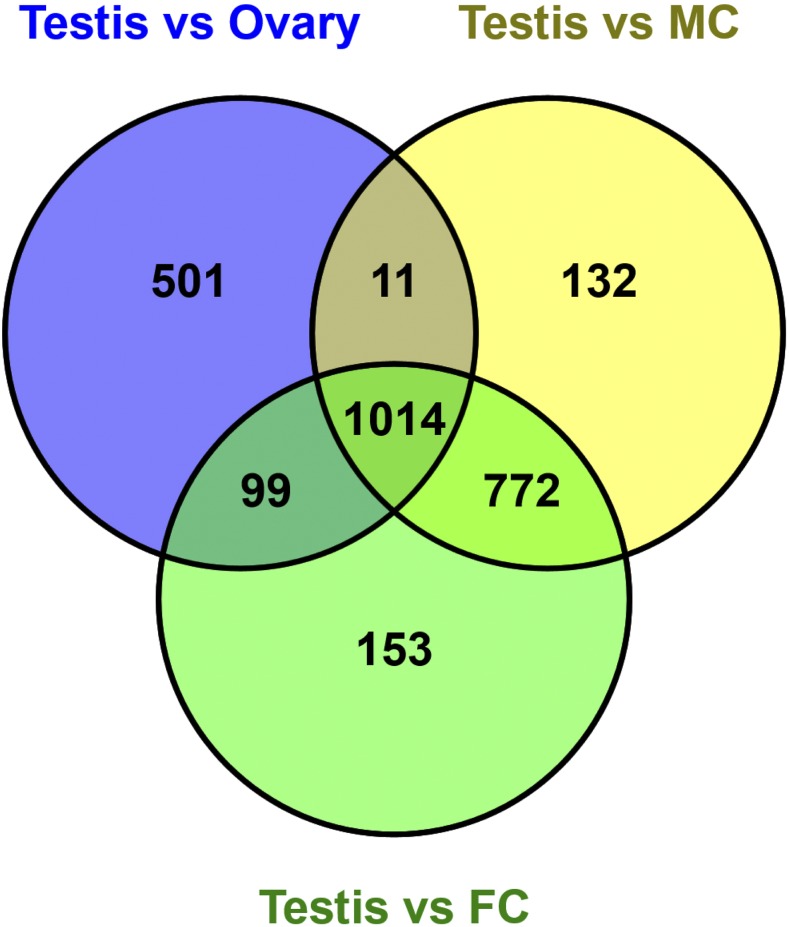
Differential increased gene expression in the Tribolium testis. Venn diagrams showing highly expressed genes in the Tribolium testis compared to ovary, male and female carcasses.